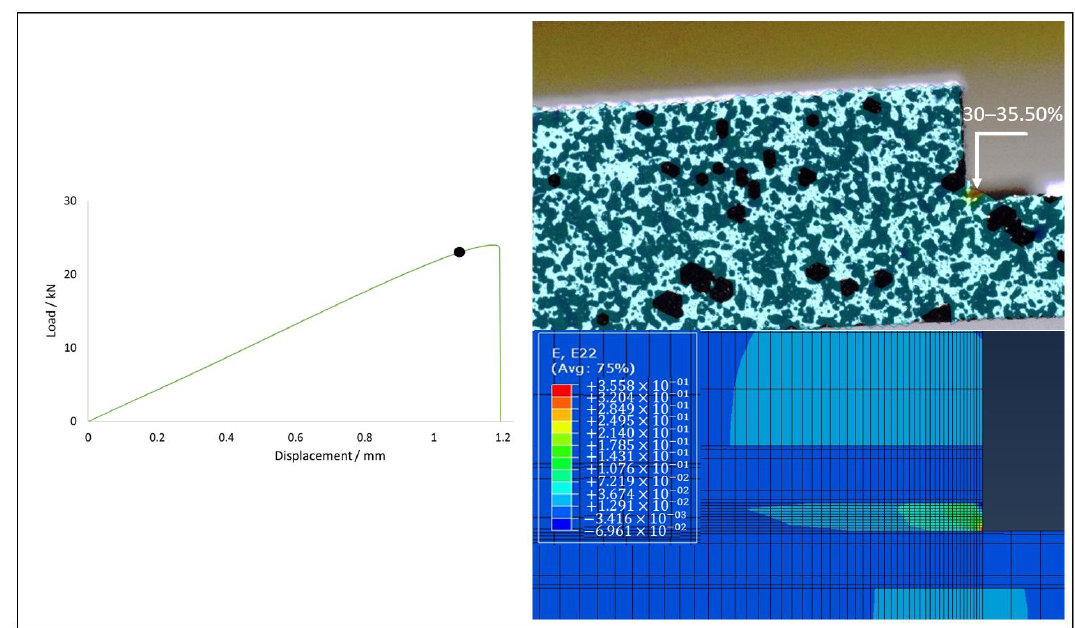
Figure 14. Strain field in CFRP-Al joint: DIC (top) vs. numerical (bottom).